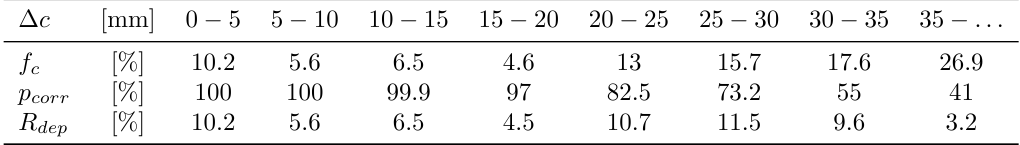
Table 2. Proportion, f c , of imaginary cover depth measurements falling within the range ∆ c , probability of occurrence of corrosion, pcorr, and extent of corroding reinforcement, R dep , in each depth ∆ c